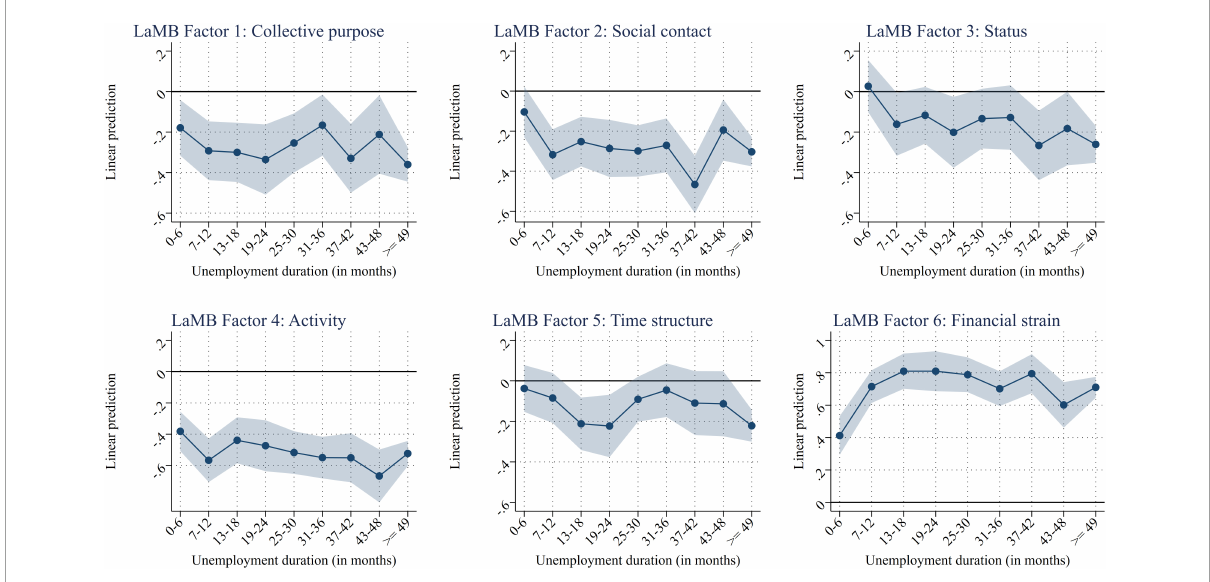
FIGURE4 Conditional on unemployment: predicted scores by monthly unemployment duration categories (net of age, age squared, gender, education, partner in HH, child (under 15) in HH, and interview mode). Supplementary Appendix Table A8 shows the corresponding regression results.